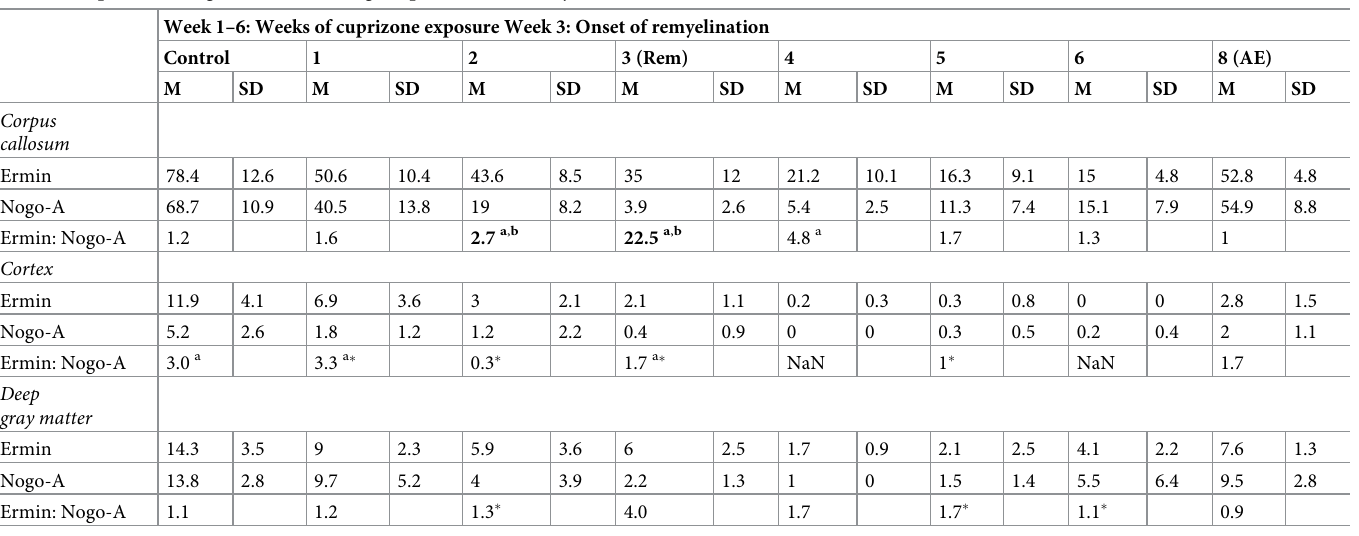
Table 2. Sequential change of ermin and Nogo-A positive cell density and their